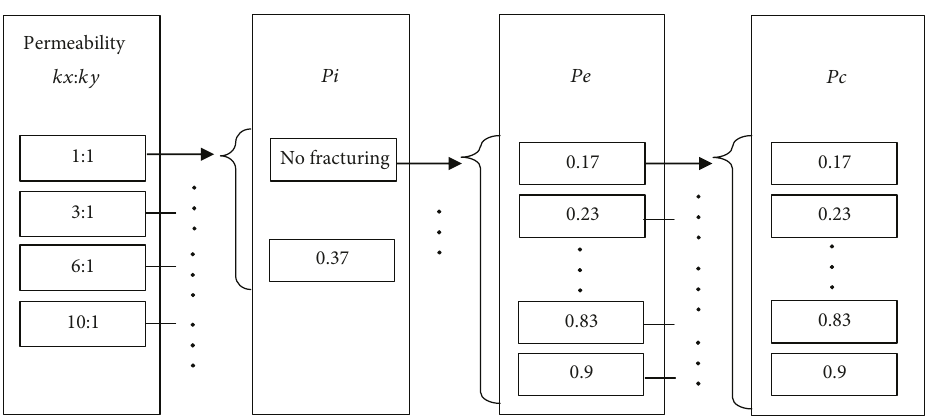
Figure 4: Schemes parameters settings block